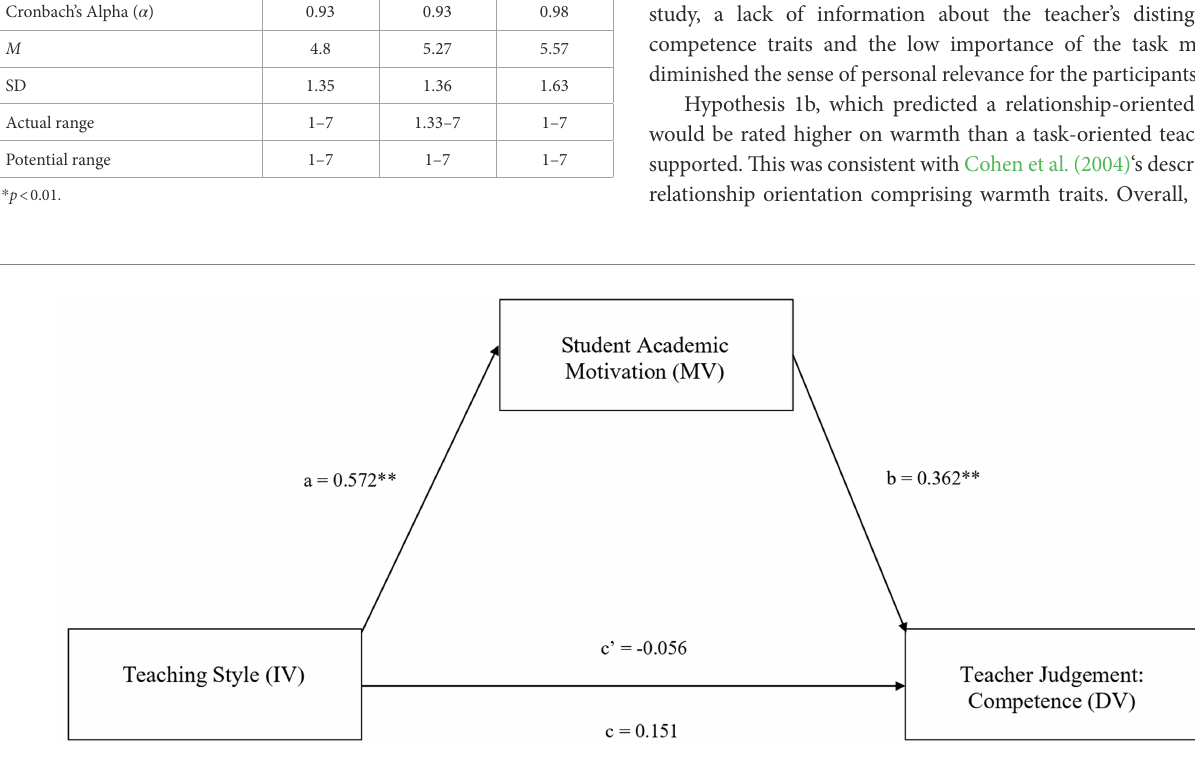
FIGURE 2 The mediating effect of student academic motivation on the relationship between teaching style and the SET dimension of competence. ** p <